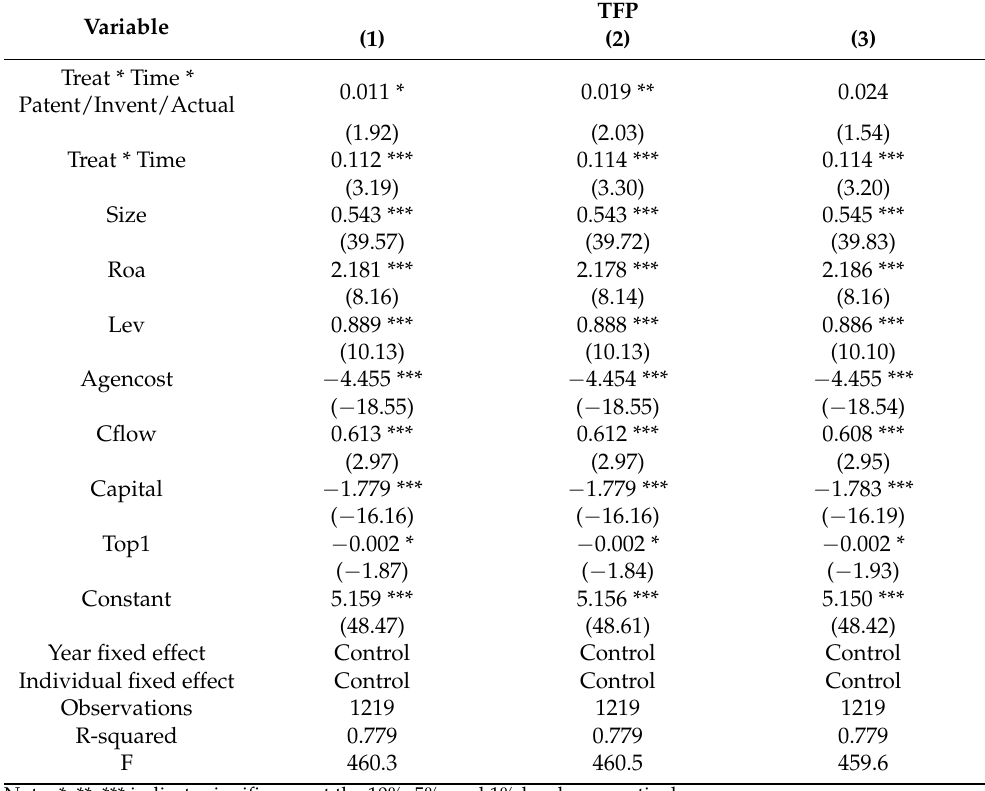
Table 6. Mechanism